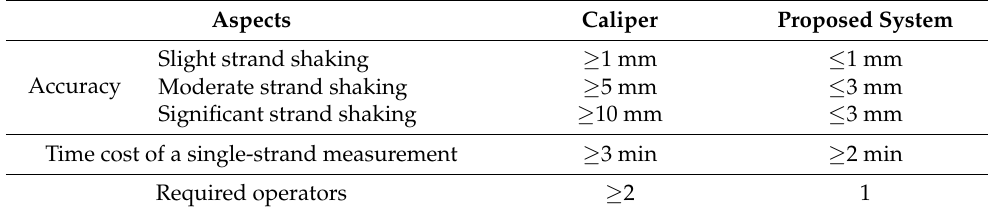
Table 7. Comparison between the traditional measuring method and the proposed measuring